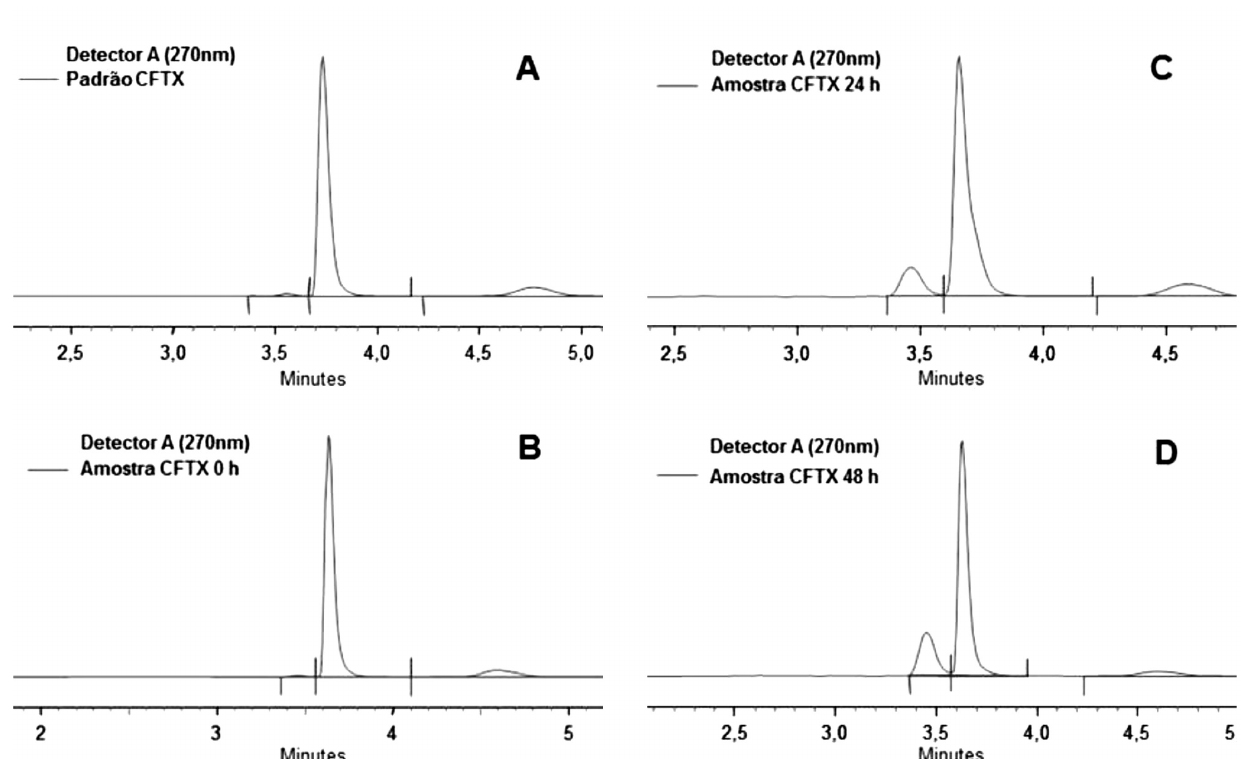
FIGURE 3 - Chromatograms of the CFTX reference standard (A). Freshly prepared sample (B). Sample after exposure to dry heat at 50 ºC for 24 h (C) and 48 h (D). The CFTX main peak is at 3.7 min. The chromatographic parameters were λ=270-nm, C18 column and mobile phase (water, acetonitrile, buffer solution pH 7, buffer solution pH 5 – 552:400:44:4) containing 0.32% of tetraheptylammonium bromide was used at a flow rate of 2